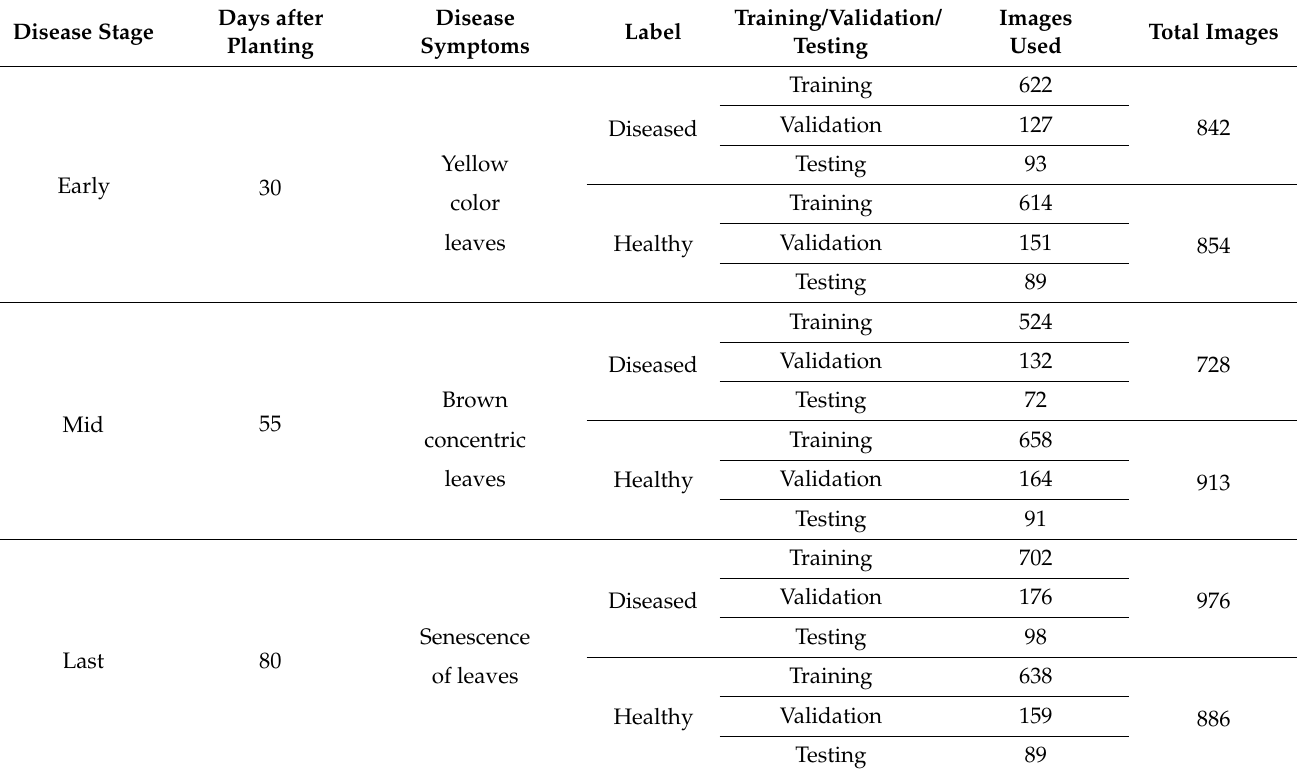
Table 1. Number of images used for training and validation to identify the disease stages for selected fields. Disease